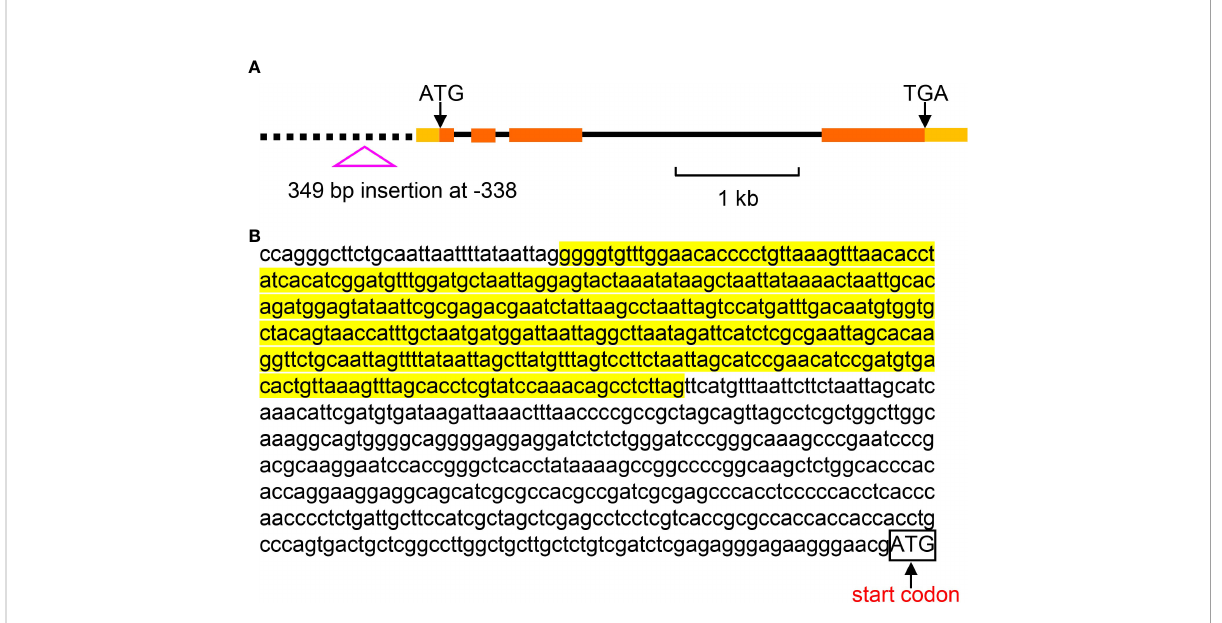
FIGURE 9 The large InDel in the promoter region of SiNRT1.1B2 . (A) The genomic structure of SiNRT1.1B2 gene and the large InDel in the promoter. Exons, introns and promoter are denoted by fi lled boxes, lines and dash line, respectively. (B) The nucleotide sequence of the large InDel in the promoter of SiNRT1.1B2 . The highlighted fragment indicates the 349 bp InDel. The box refers to the start